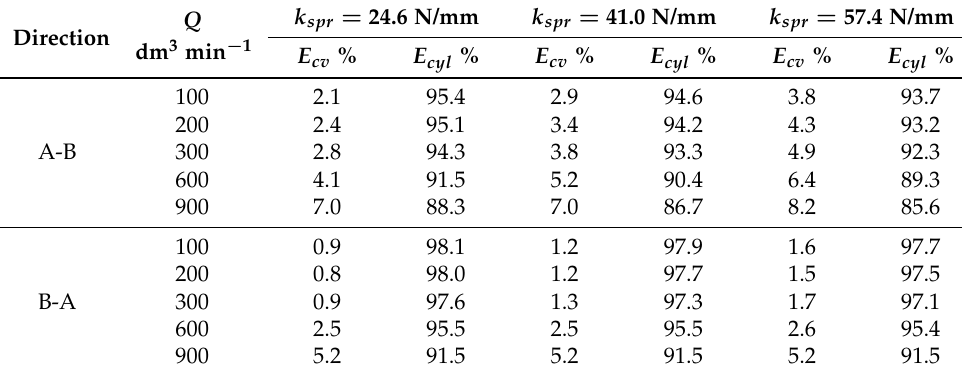
Table 7. Percentage share of energy consumption by the check valve E cv and the hydraulic cylinder E cyl against flow rate Q and spring stiffness k spr